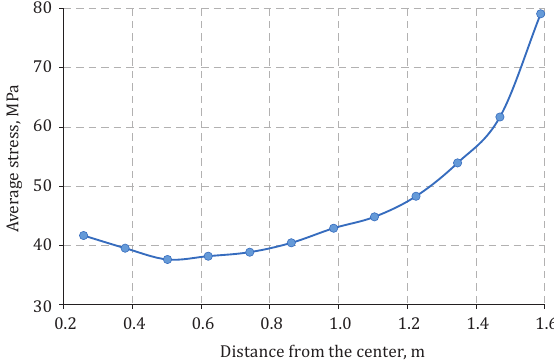
Figure 10. Stress distribution of each slide plate for the original design